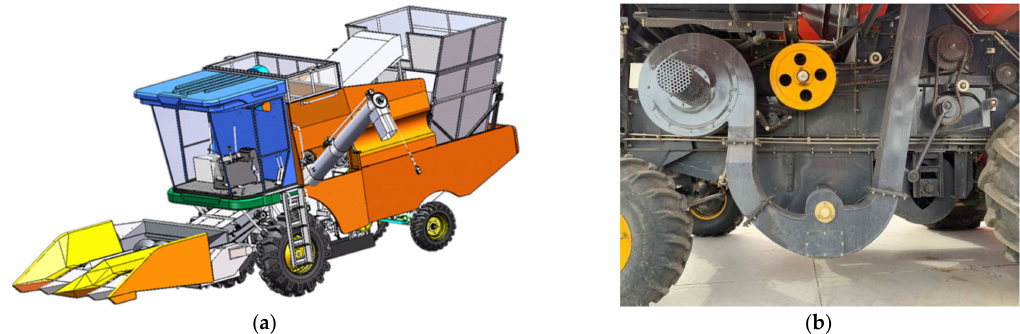
Figure 1. 4ZXRKS-4 type self-propelled sunflower combine harvester: ( a ) sunflower combine har- vester structure sketch; and ( b ) pneumatic conveying